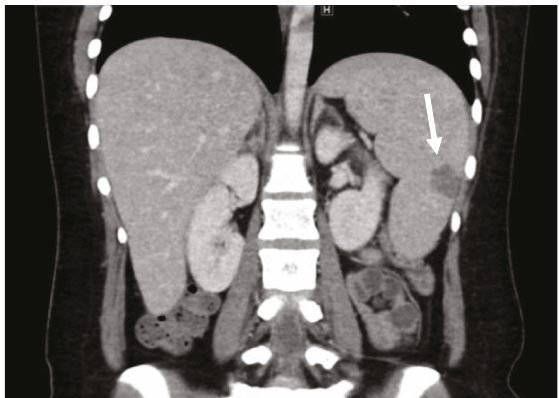
Figure 2: Hepatosplenomegaly with multiple splenic hypodensities consistent with splenic infarction (arrow) after using